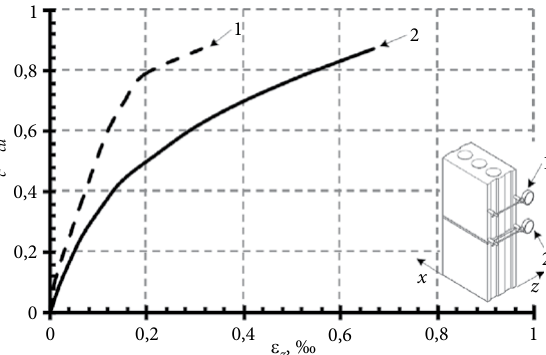
4 pav. Horizontaliųjų deformacijų e priklausomybė nuo z gniuždymo įtempių bloko viduryje (1) ir prie gulsčiosios – ribiniai įtempiai siūlės (2); čia s cu on axial Fig. 4. The dependence of horizontal strain e z ( s ) on the compression in the middle of the block (1) and near bx bz / E and thickness of bed joint – critical the bed joint (2); s b m cu